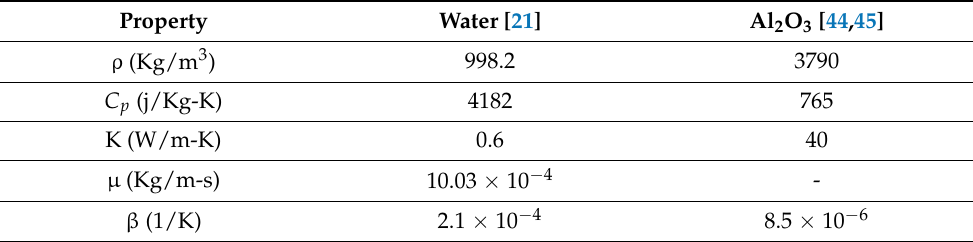
Table 1. Thermo-physical properties of base fluid and nanoparticles at 293 K.